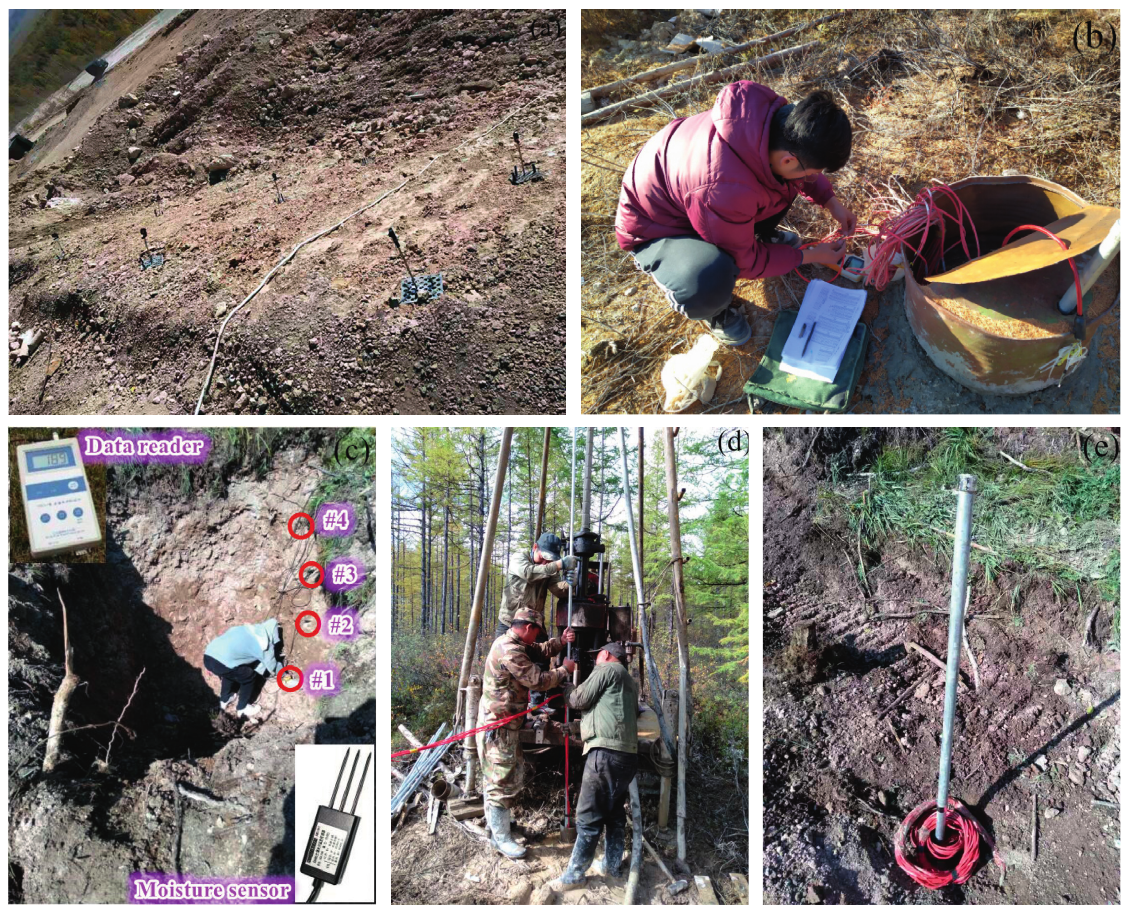
Figure 4: Monitoring site layout. (a) The arrangement of observation points on the slope; (b) the measurement process of the temperature data; (c) the arrangement of the moisture sensors; (d) the construction process of temperature sensors; and (e) the datum point when measuring the